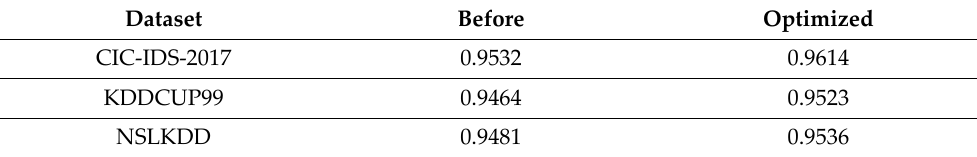
Table 6. Algorithm optimization experiment accuracy comparison results.